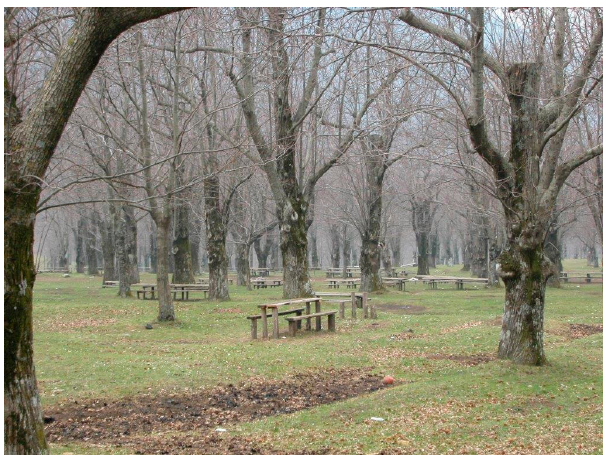
Figure 2. Representation of disappearance/transformation scenario. Land 2020 , 9 , x FOR PEER REVIEW